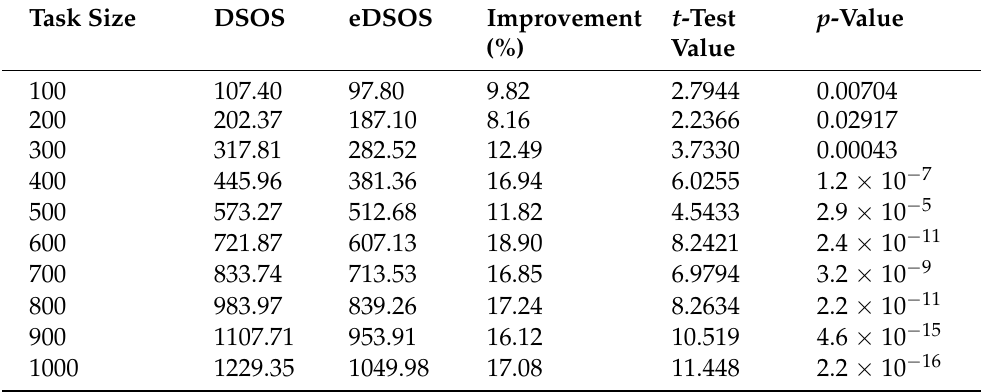
Table 8. Comparison of the makespans of DSOS and eDSOS for the uniformly distributed dataset.